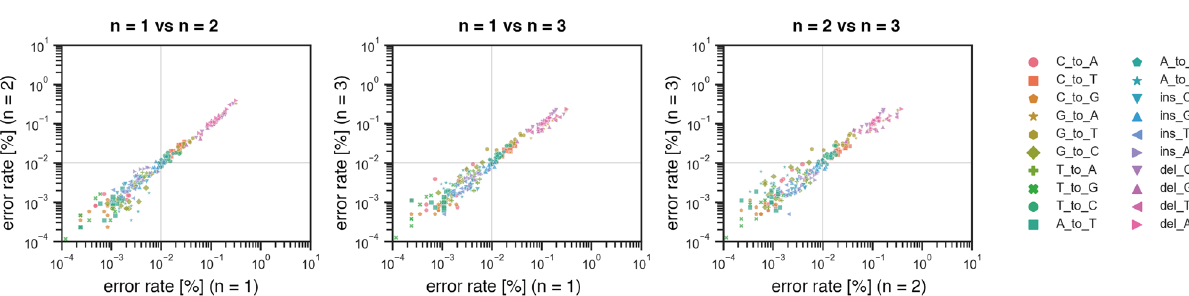
Figure 3. Reproducibility of observed error rates. Three oligonucleotides synthesized independently using the same synthetic conditions were compared. The synthetic conditions are 1 H -tetrazole in anhydrous acetonitrile as an activator, acetic anhydride in THF as a capping reagent A, 10% 1-methylimidazole in 10% pyridine- THF as a capping reagent B, 0.02 M I 2 in THF/pyridine/H 2 O (90:<1:10, v/v/v) as an oxidation reagent, and 3% trichloroacetic acid in dichloromethane (TCA) as a deblocking reagent. Q5 High-Fidelity DNA polymerase was used for assembling